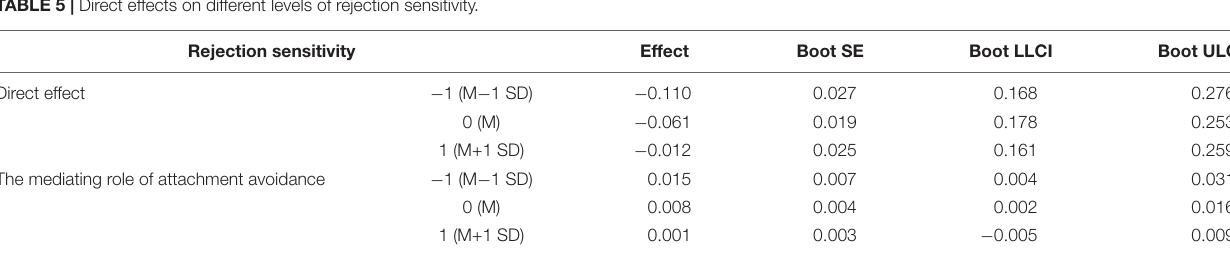
FIGURE 2 | The rejection sensitivity moderates life satisfaction and attachment avoidance. TABLE 5 | Direct effects on different levels of rejection